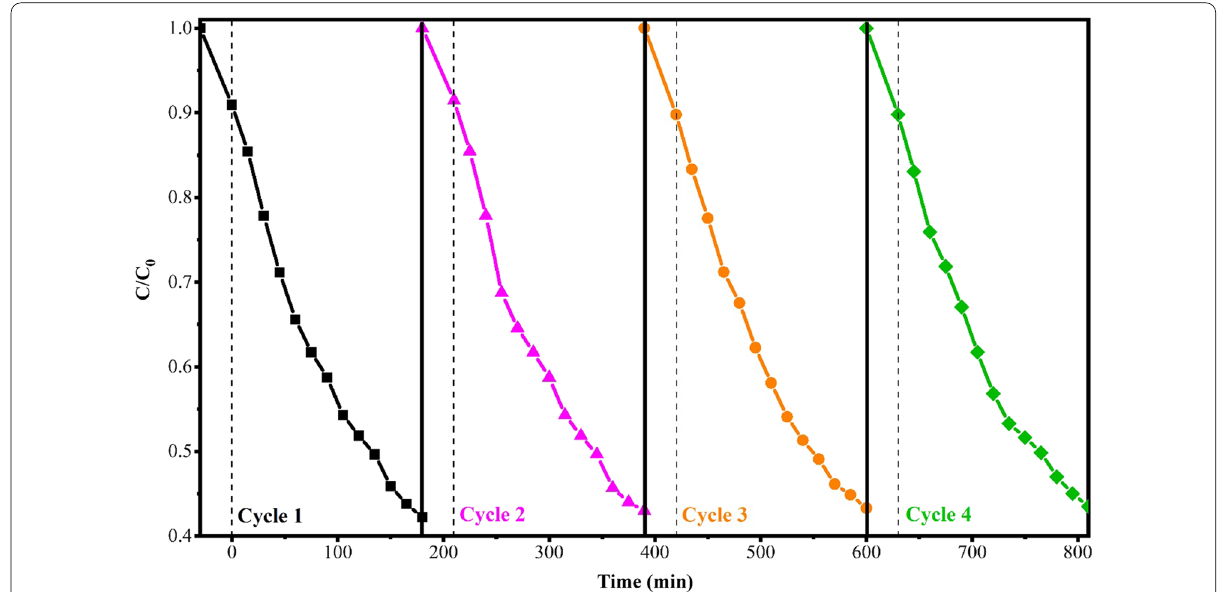
Fig. 8 Photocatalytic stability test of Bi 2 O 3 /Bi 2 O 2 CO 3 /(BiO) 4 CO 3 (OH) 2